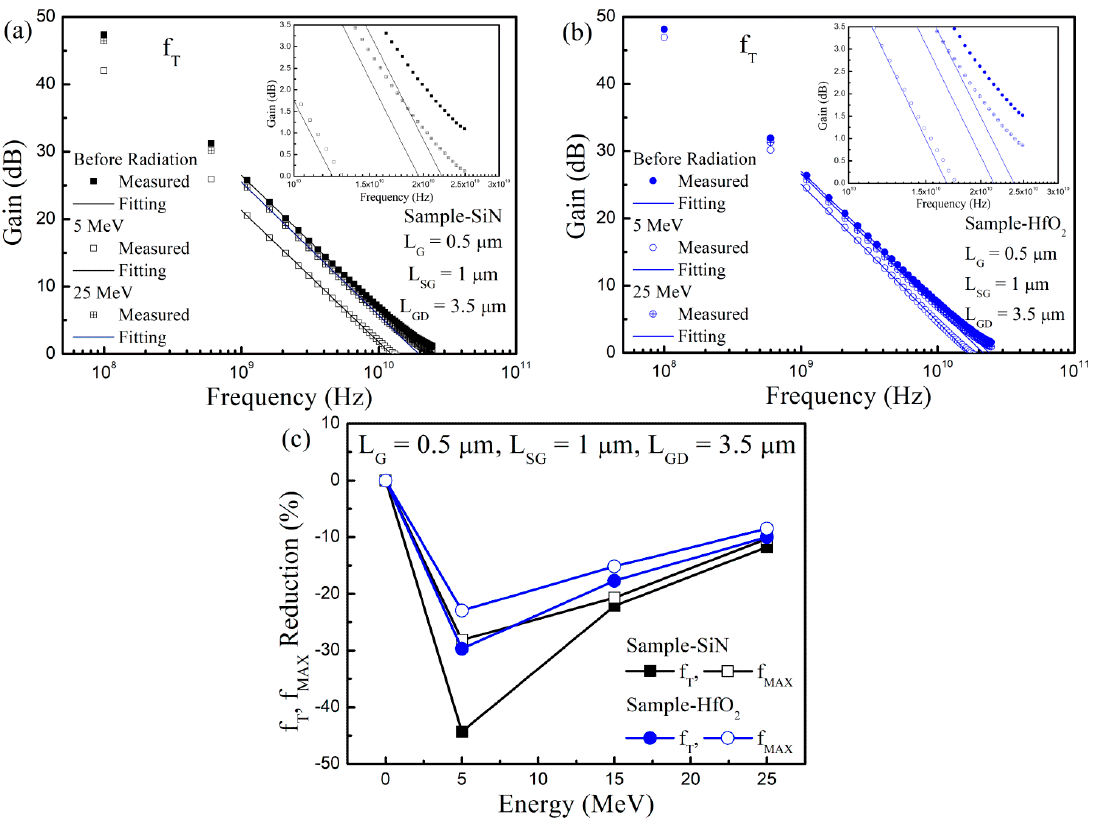
Figure 7. Radio-frequency performance investigation, such as cut-off and maximum oscillation frequency before and after proton irradiation in the GaN-based MIS-HEMTs for the 5 nm-thick Si 3 N 4 and HfO 2 gate insulator. Cut-off frequency characteristics before and after proton irradiation in GaN-based MIS-HEMTs for a 5 nm-thick ( a ) Si 3 N 4 and ( b ) HfO 2 gate insulator. ( c ) Extracted cut-off frequency and maximum oscillation frequency as a function of the irradiated proton energy.